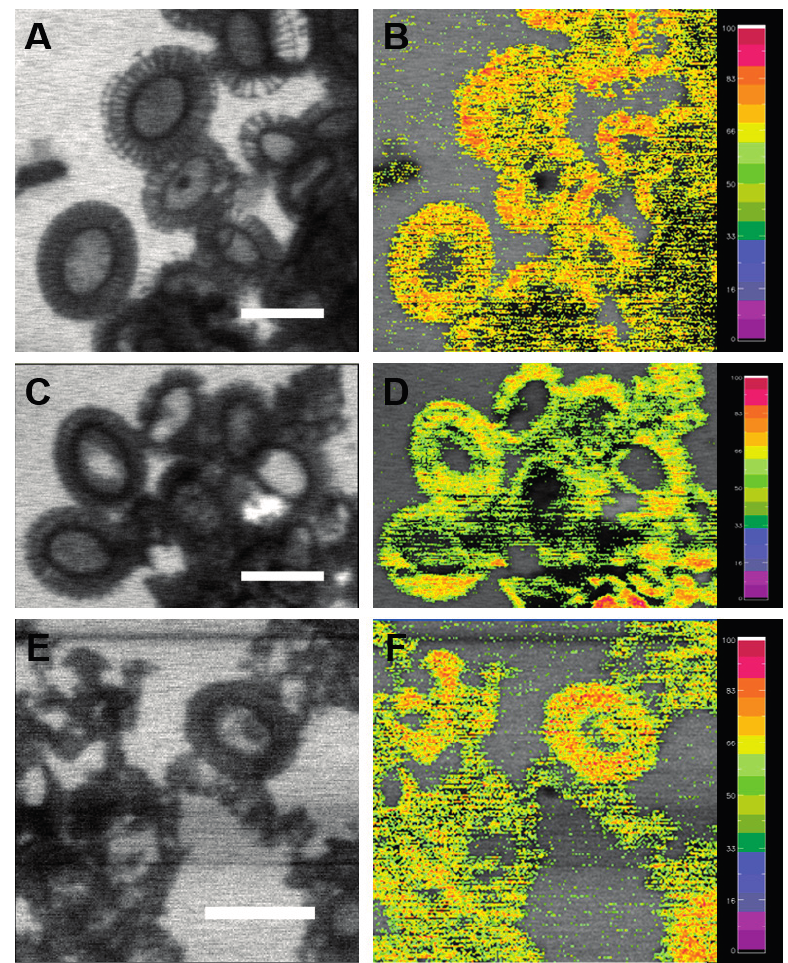
Figure 7. Dual energy (347.7 and 345 eV) contrast images of total Ca in coccoliths of E. huxleyi in the presence of different Sr concentrations using STXM. ( A , B ) and ( B ) 0 ppm Sr in original culture medium; ( C , D ) 50 ppm Sr in original culture medium; ( E , F ) 100 ppm Sr in original culture medium; ( A , C , E ) Ca mapping at 347.7 eV; ( B , D , F ) Color overlay from the difference of 347.7 and 345 eV images showing the specific distribution of Ca with gradients. Scale bars: 1 μ m.